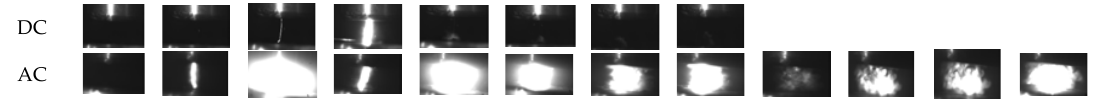
( b ) Figure 7. The breakdown voltages of the oil-impregnated pressboard. ( a ) The DC breakdown voltages; and ( b ) the AC breakdown voltages (effective values). Table 4. Statistics of the oil-impregnated pressboard breakdown voltages (BDV). Electrode Systems